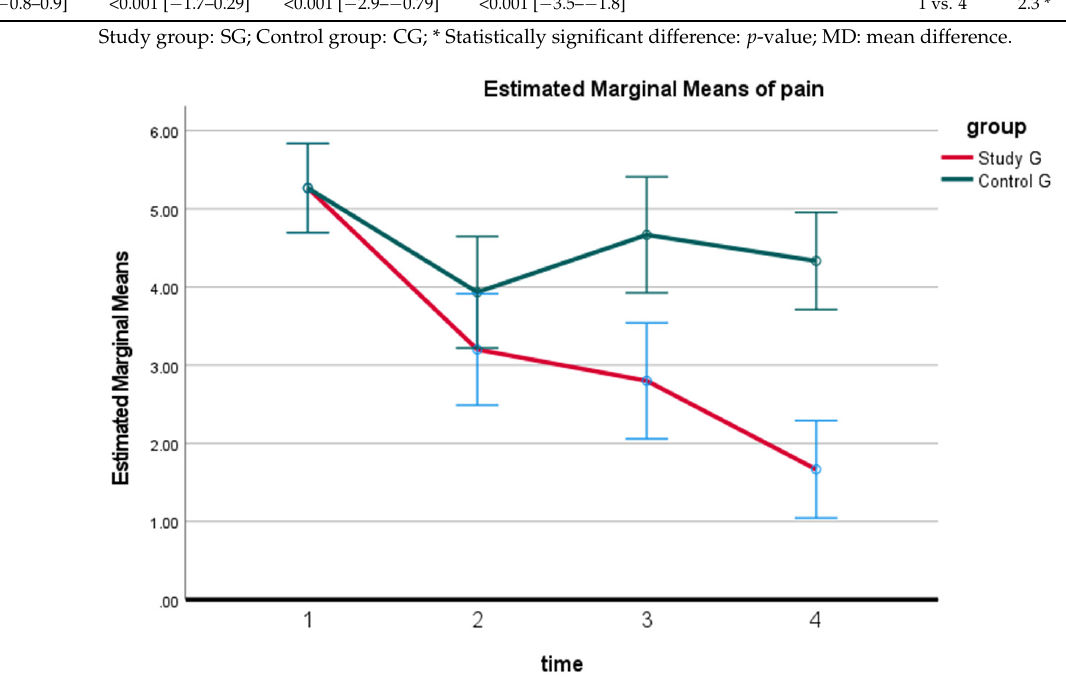
Table 2. The results for the repeated measures one-way analysis of variance (ANOVA) for the ab- solute rotation angle (ARA) cervical lordosis and pain intensity in both groups.